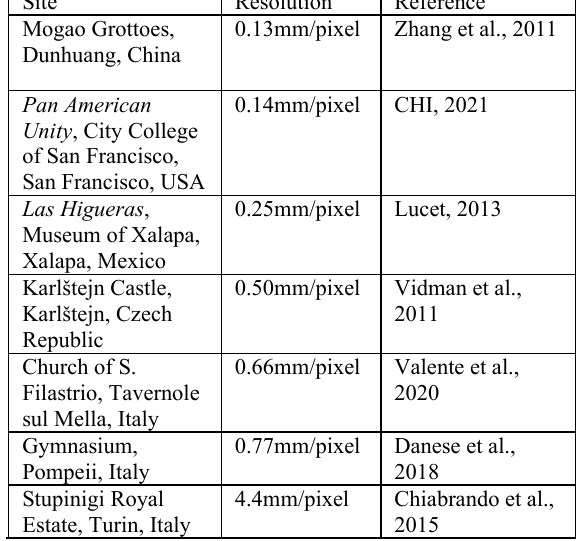
Table 1. Recent published photogrammetric surveys of wall paintings and their spatial